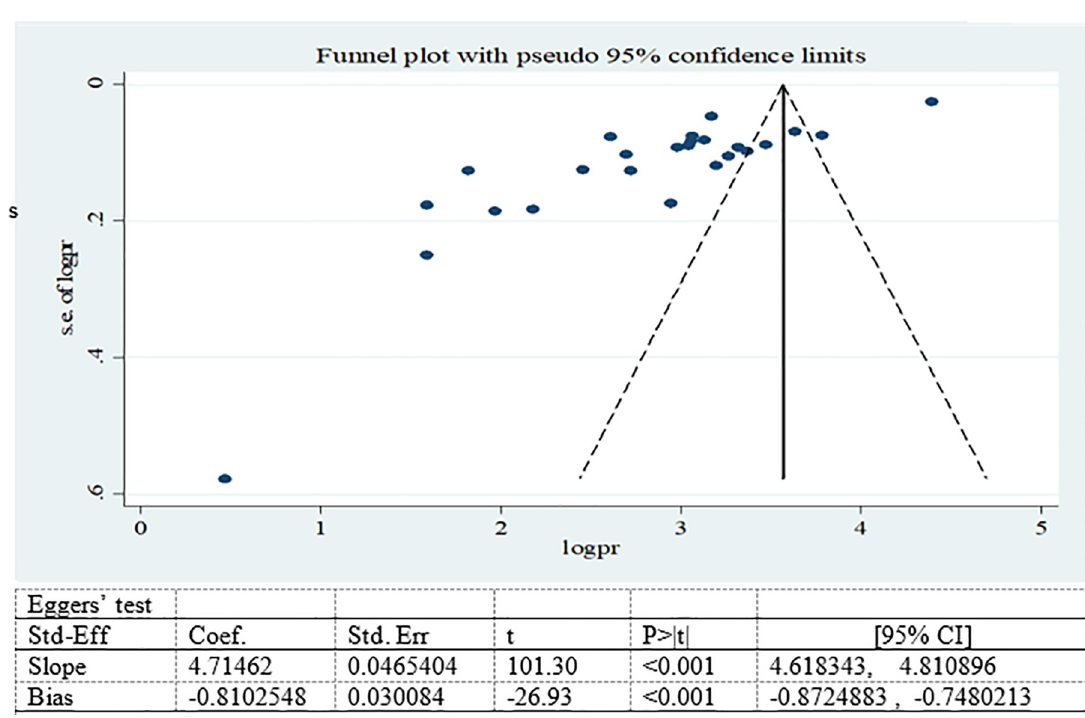
Fig 9. Funnel plot and Eggers’ test to assess publication bias for adolescent thinness in Ethiopia.